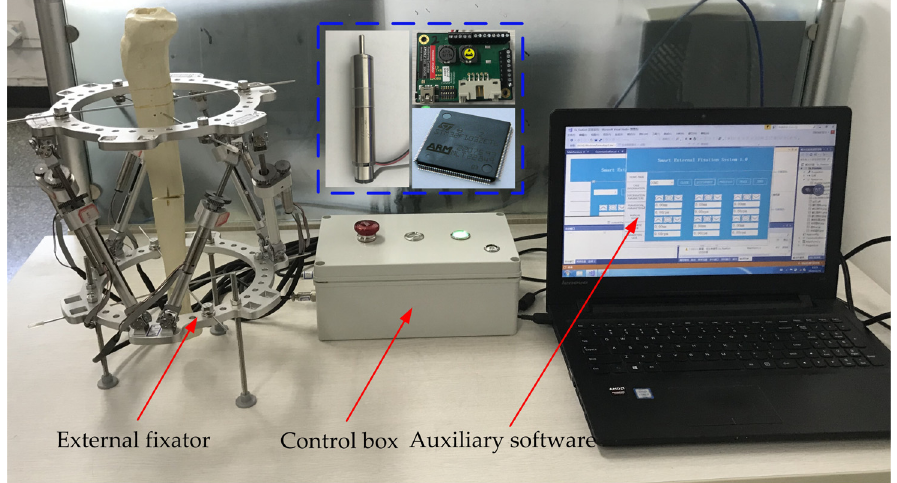
Figure 2. The overview of the system configuration.